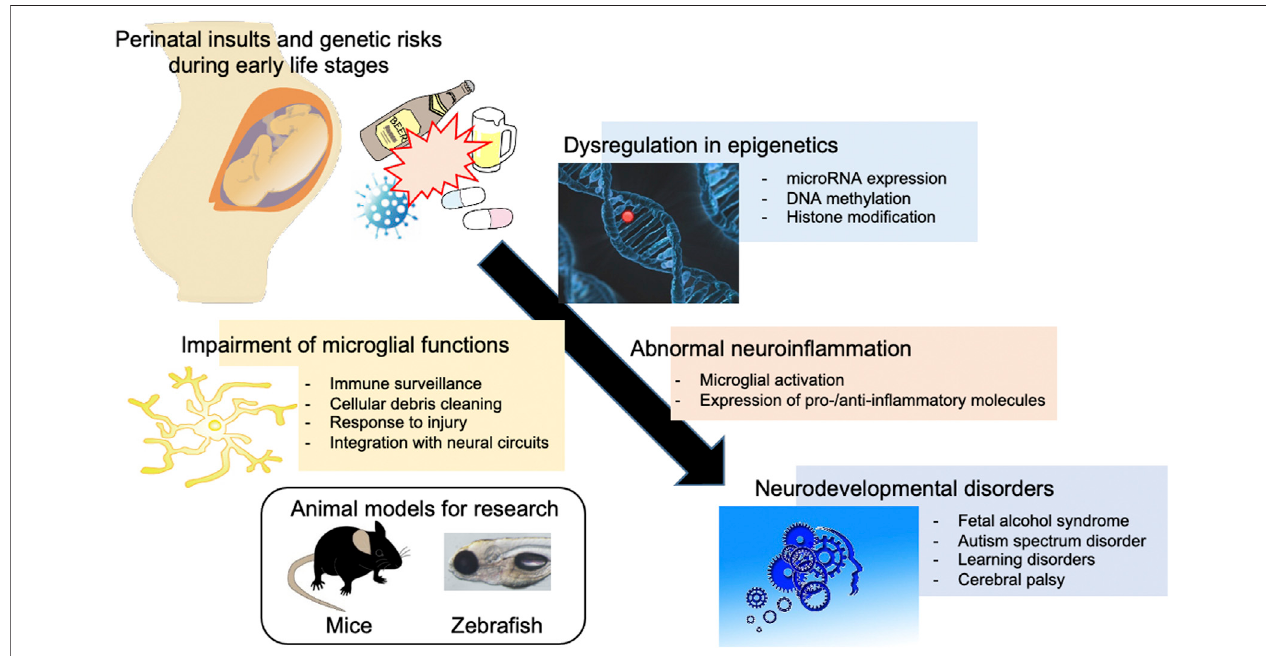
FIGURE 1 | Involvement of environmental and genetic factors in the epigenetic dysregulation and neuroin fl ammation associated with neurodevelopmental disorders. Perinatal environmental insults such as alcohol and cocaine exposure during development and/or genetic risks such as mutation of MECP2 and UHRF1 can cause epigenetic dysregulation in microglia, including the expression of microRNAs important for the development and function of microglia, leading to neuroin fl ammation and neurodevelopmental disorders. Zebra fi sh, as well as rodents, can be used to analyze the effect of such factors.